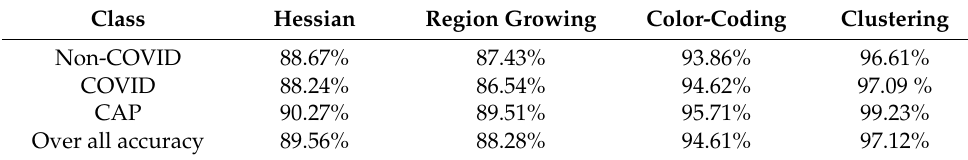
Table 6. Per-class accuracy of all methods with CNN modified with attention mechanism and LSTM.